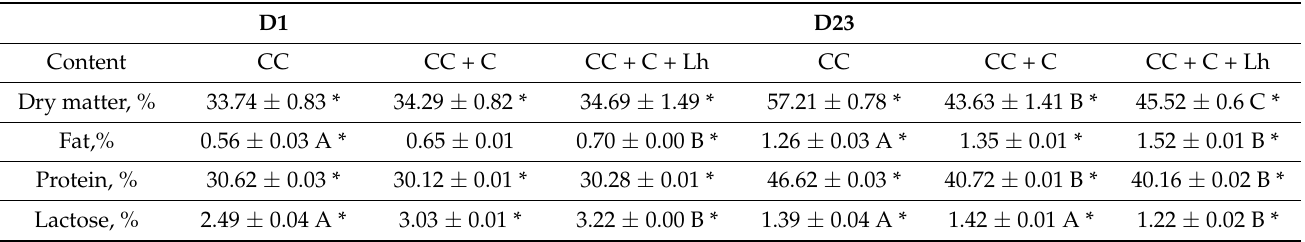
Table 1. Chemical compositions of curd cheese treatments during cold storage. D1